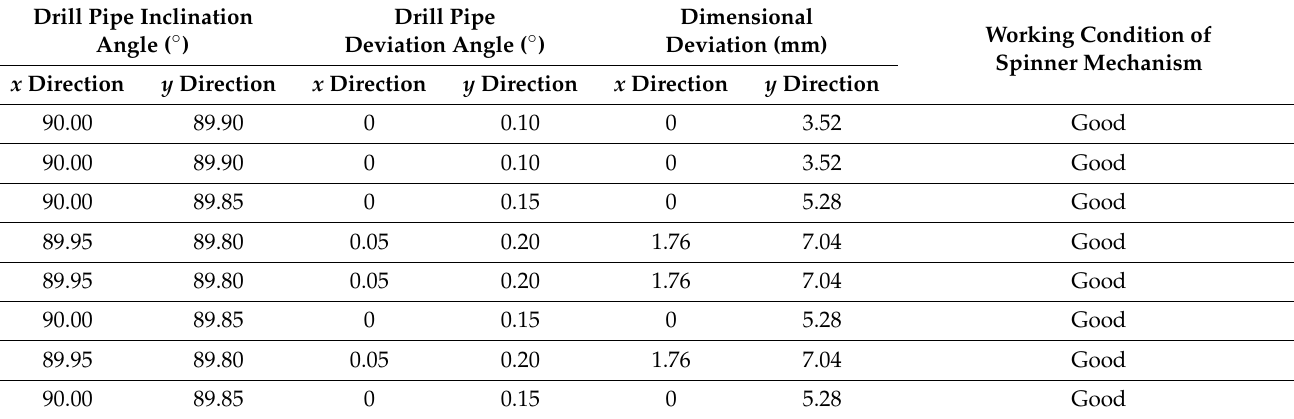
Table 5. Position deviation of the drill pipe and spin condition of the spinner mechanism with double follow-up